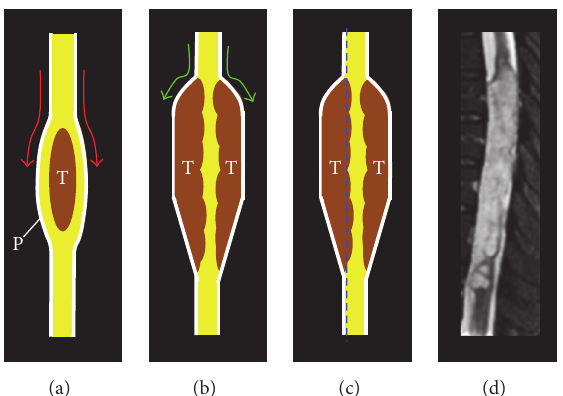
Figure 4: Schematic representation of MRI findings for spinal subependymoma demonstrating the bamboo leaf sign. (a) Other intramedullary tumors like ependymoma and astrocytoma show gradual dilatation of the spinal cord. (b) Spinal subependymoma shows steep swelling of the spinal cord due to subpial growth. (c) Blue dashed line shows sagittal section for MRI of the spinal subependymoma. (d)